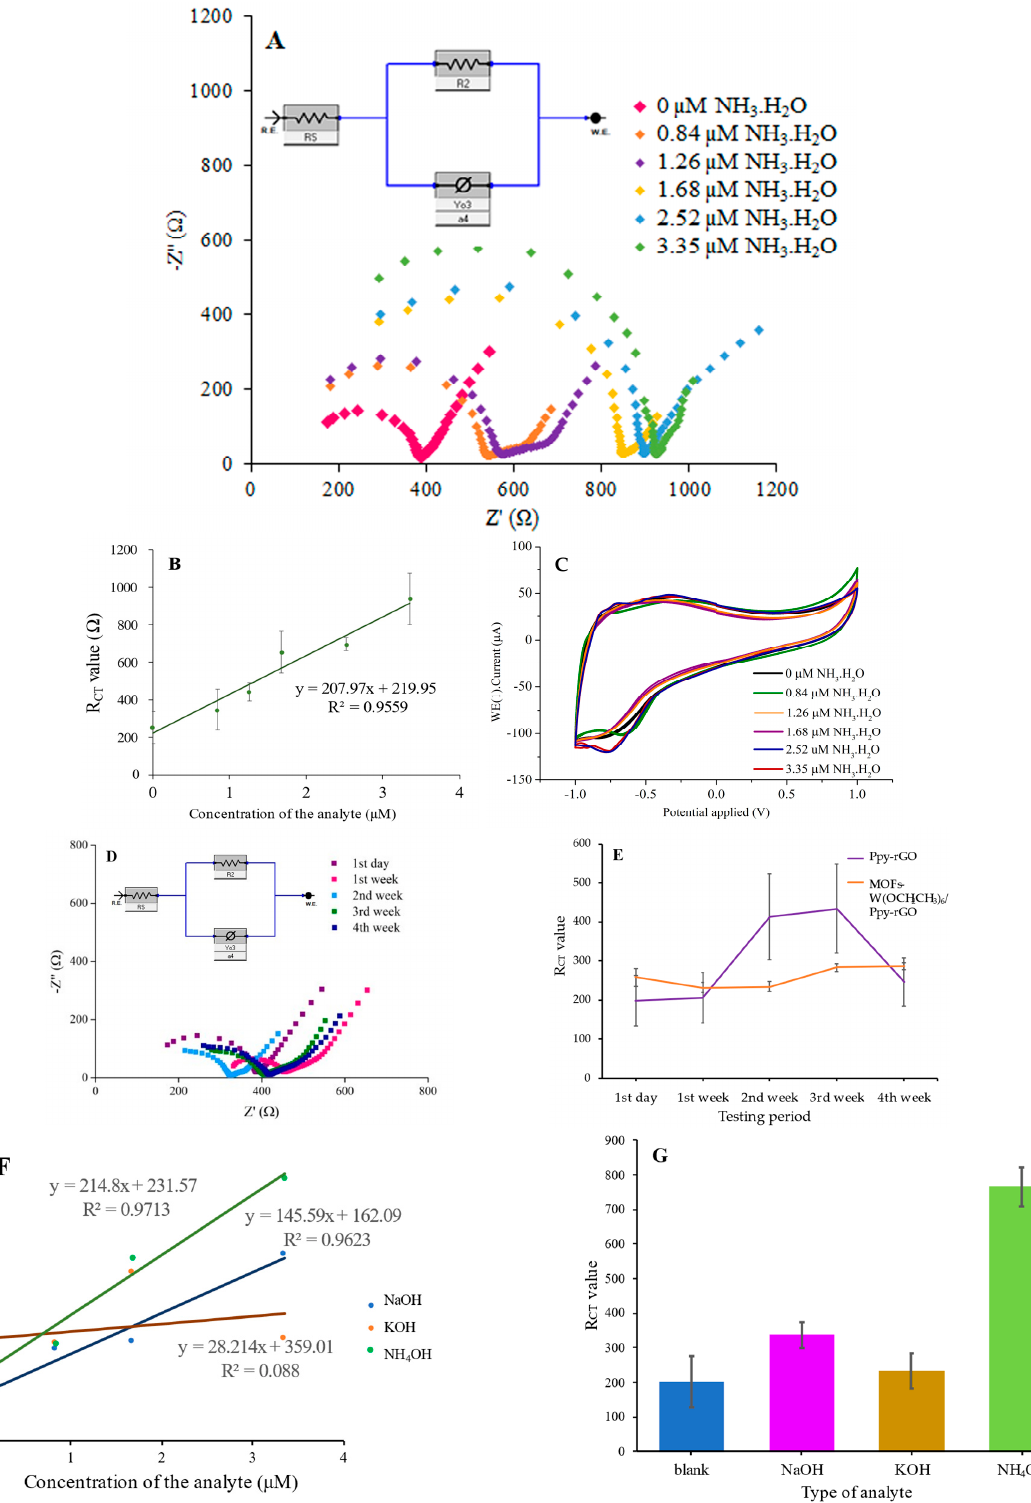
Figure 4. ( A ) EIS curve and the fitted equivalent circuit; ( B ) regression linear plot; ( C ) CV curve at different concentrations in an OPW between − 1.0 to 1.0 V; ( D ) EIS curve of the stabil- ity test for MOFs-W(OCH 2 CH 3 ) 6 /Ppy-rGO; ( E ) the stability performance comparison of MOFs- W(OCH 2 CH 3 ) 6 /Ppy-rGO and Ppy-rGO; ( F ) regression linear plot of MOFs-W(OCH 2 CH 3 ) 6 /Ppy-rGO drop-casted by NaOH, KOH and NH 4 OH analytes; and ( G ) the selectivity performance of MOFs- W(OCH 2 CH 3 ) 6 /Ppy-rGO upon detection of NH 4+ , K + , and Na + ions. The Nyquist plots portrayed a depressed semi-circle and a spike in the high- and low- frequency ranges. EIS was carried out to illustrate and explore the sensing performance of MOFs-W(OCH 2 CH 3 ) 6 /Ppy-rGO nanocomposite. The semi-circle diameter on the ab- scissa of the Nyquist plot in the high-frequency range of the electrochemical systems was a tt ributed to the charge-transfer resistance (R ct ). Meanwhile, the lower value of R ct indi- cated a higher conductivity with a high ion transfer or di ff usion rate into the electrodes. Impedance measurements usually generate Nyquist plots that can be categorized into three types. (i) a depressed semi-circle, (ii) a tilted spike, or (iii) a depressed semi-circle Nyquist plot with a tilted spike. A depressed semi-circle was formed when a constant phase element with a resistor connected in parallel was present in an equivalent circuit, as shown in Figure 4A,D. The constant phase element (CPE) or “leaky capacitor,” which is connected in series with a resistor, can be observed by the plot as a shape of a spike. Thus, the Nyquist plot that appears with a depressed semi-circle and a tilted spike corre- sponds to a combination of a parallel connection of a resistor and CPE that are connected in series with another resistor or CPE. The depressed semi-circle corresponds to the bulk material, while the tilted spike represents the electrical double layer. The electrochemical sensor showed remarkable stability with repetitive detection of NH 4+ ions for four weeks consecutively at RT and a subsequent washing process with PBS solution (Table S5 and S6). The improved stability of MOFs-W(OCH 2 CH 3 ) 6 /Ppy-rGO as compared to Ppy-rGO is due to the presence of tungsten, as discussed earlier in Raman and XPS analyses. The re- dox peak current has increased correspondingly to an increment of scan rate from 20 mVs − 1 to 100 mVs − 1 , as con fi rmed by linear regression with an R 2 of 0.9559 as shown in Figure S6A. The LOD and LOQ were used to measure the sensitivity of the sensor based on the concentration of ammonium solution. LOD is the minimum number of analytes a sensor can detect. Meanwhile, LOQ is the smallest amount of the minimum concentration of a substance that is possible to determine with acceptable precision, accuracy, and uncer- tainty. Both LOD and LOQ values were analyzed using regression analysis and calculated using the formula equation as followed: LOD = 3.3 (cid:3400) SD m